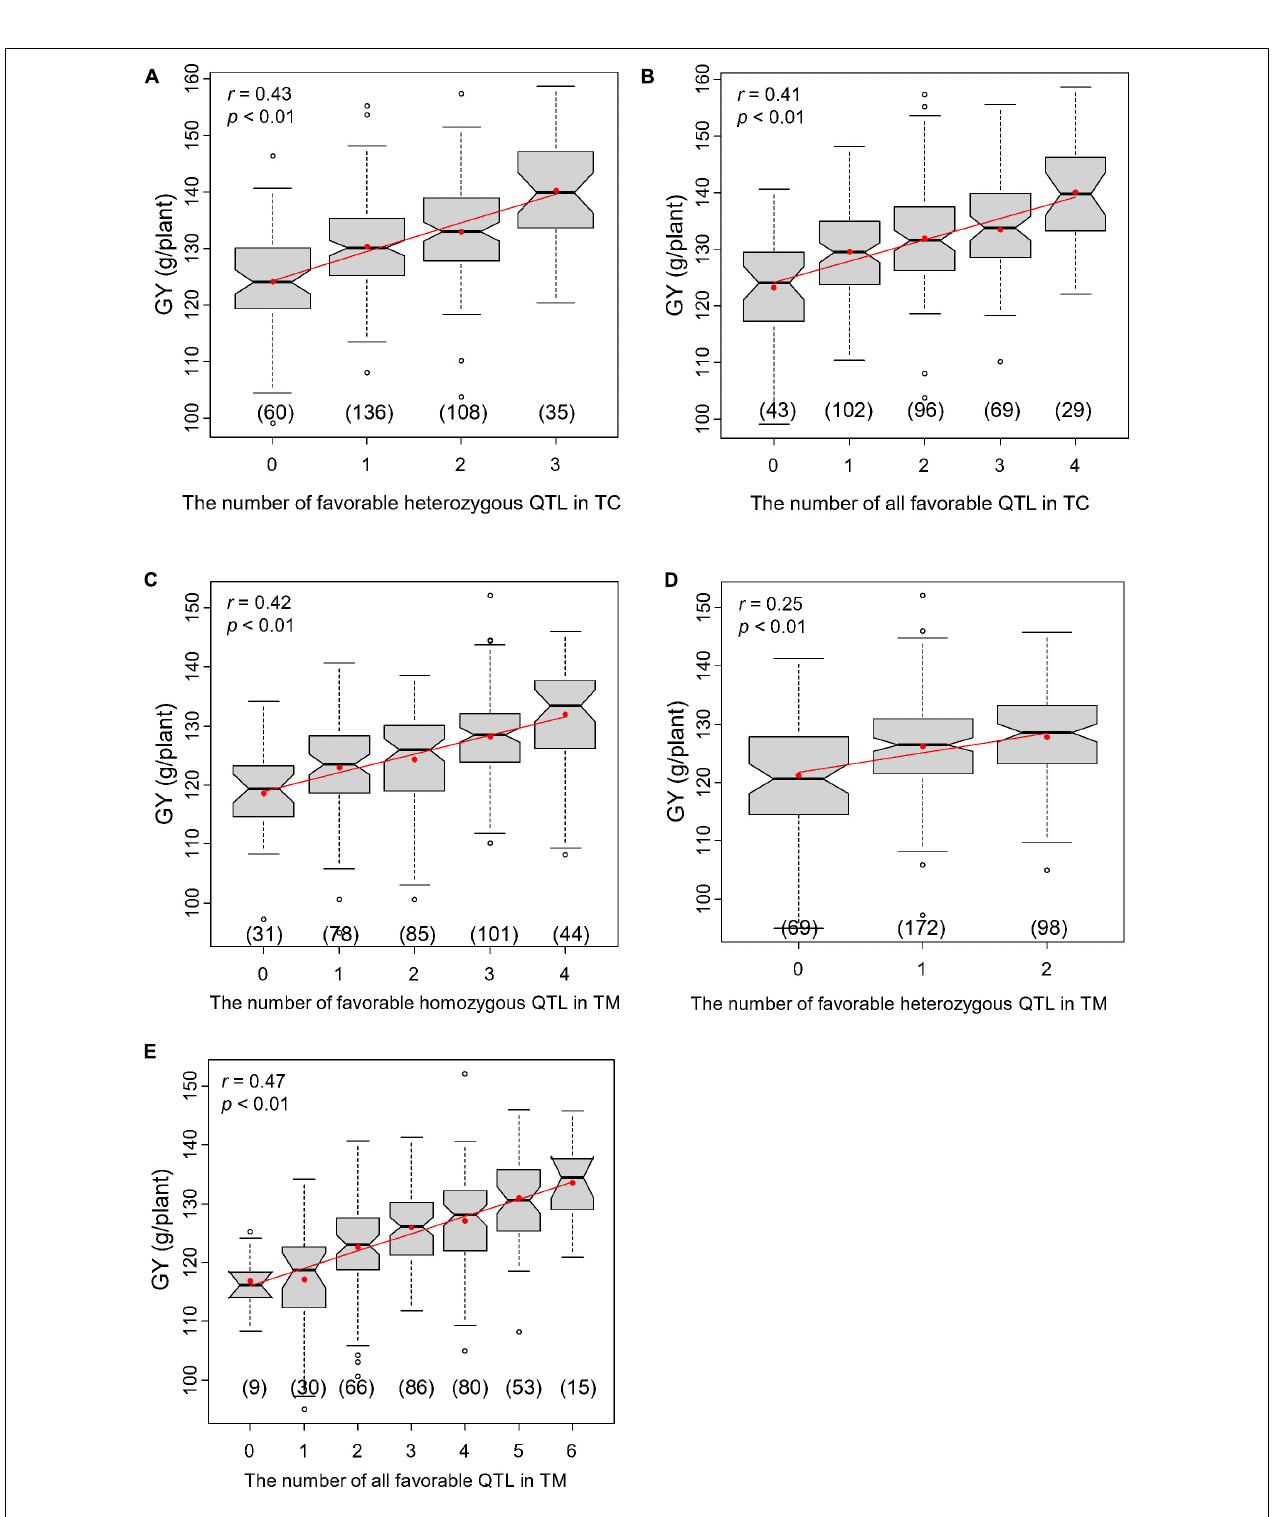
FIGURE 6 | Correlations between the number of favorable quantitative trait loci (QTL) and grain yield per plant (GY). (A) Correlation between the number of all favorable QTL and GY in Chang7-2 × RIL (TC) population and (B) between the number of favorable heterozygous QTL and GY in TC population. (C) Correlation between the number of all favorable QTL and GY in Mo17 × RIL (TM) population and (D) between the number of favorable heterozygous QTL and GY in TM population. (E) Correlation between the number of favorable homozygous QTL and GY in TM population.